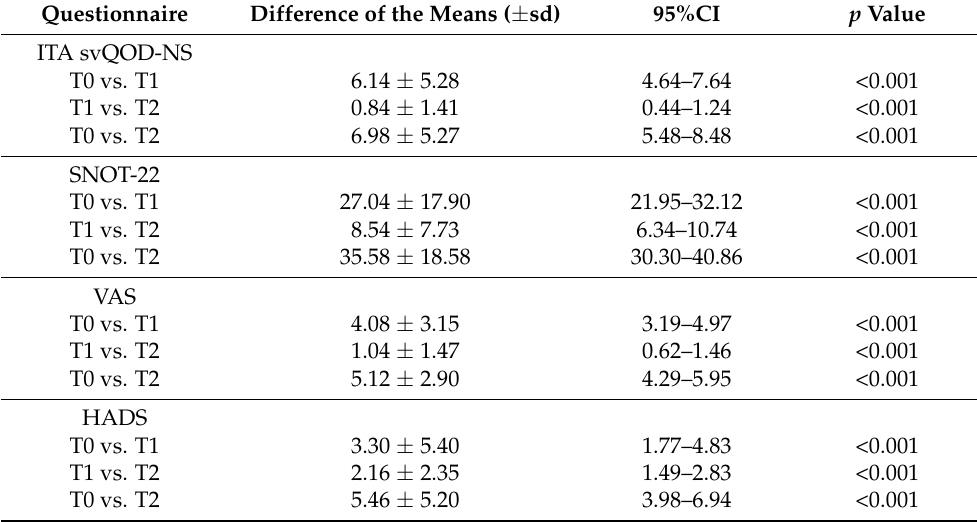
Table 6. Difference of the means of each score at different time points: pre-operatively (T0), one month (T1) and nine months after surgery (T2). sd = standard deviation; CI = confidence